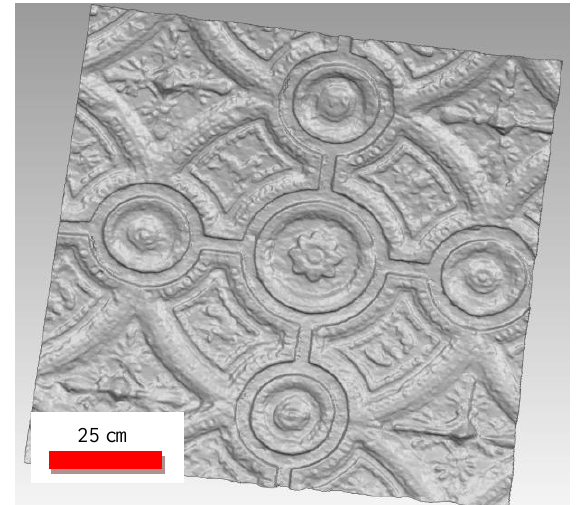
Figure 12. A detail of the surface model – Room 2